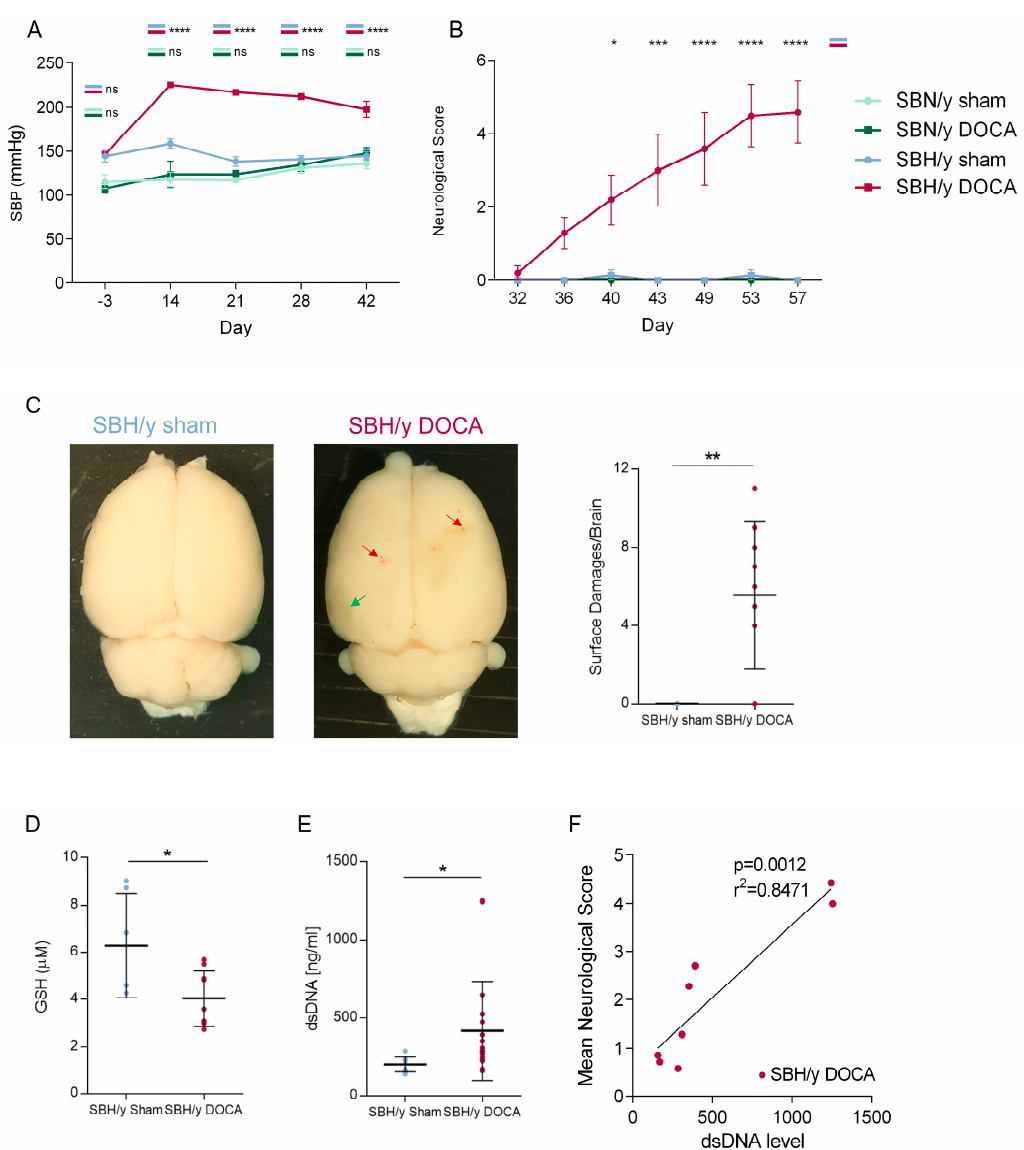
Figure 1. Hypertension, oxidative stress and neurological deficits in SBH/y-DOCA rats. Systolic blood pressure ( A ) and neurological scores ( B ) of SBH/y sham ( n = 7), SBH/y-DOCA ( n = 10), SBN/y sham ( n = 4) and SBN/y-DOCA ( n = 4) rats. Representative images and quantification ( C ) of brains derived from SBH/y sham ( n = 7) and SBH/y-DOCA ( n = 9) rats, showing superficial bleedings (red arrows) and dark ischemic regions (green arrow). Blood GSH levels in SBH/y sham ( n = 6) and SBH/y-DOCA ( n = 9) rats ( D ). dsDNA levels in plasma of SBH/y sham ( n = 11) and SBH/y-DOCA ( n = 19) rats ( E ) and a correlation of plasmatic dsDNA levels and mean neurological score (day 32 to day 57) in SBH/y-DOCA rats ( n = 8) ( F ). Data are presented as mean ± SD. * p < 0.05, ** p < 0.01, *** p < 0.001, **** p < 0.0001. Two-way ANOVA analyses in ( A , B ). Two-tailed t -test analysis in ( C – E ). Pearson’s Correlation in ( F